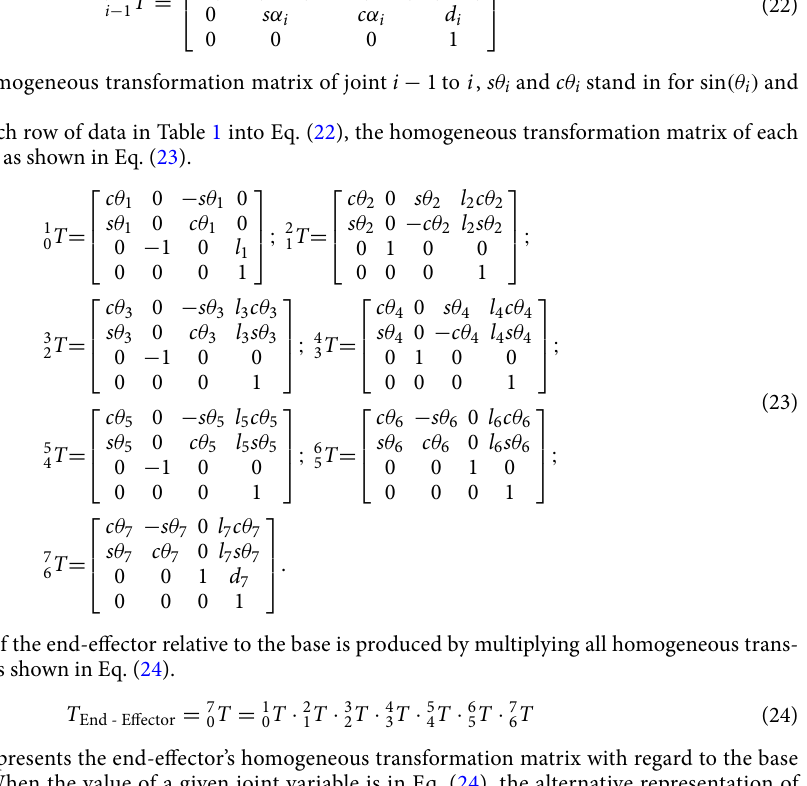
where ( p x , p y , p z ) T represents the end-effector’s position element in the base coordinate system, and ( (cid:31) n , (cid:31) s , (cid:31) a ) represents the posture element, that is, the rotation element. Although the rotation matrix ( (cid:31) n , (cid:31) s , (cid:31) a ) has nine elements, it has only three degrees of freedom and is a unit orthogonal matrix with redundancy. Therefore, the Euler angle is used to describe the posture of the end-effector, and its calculation formula is shown in Eq. (26) 66 .